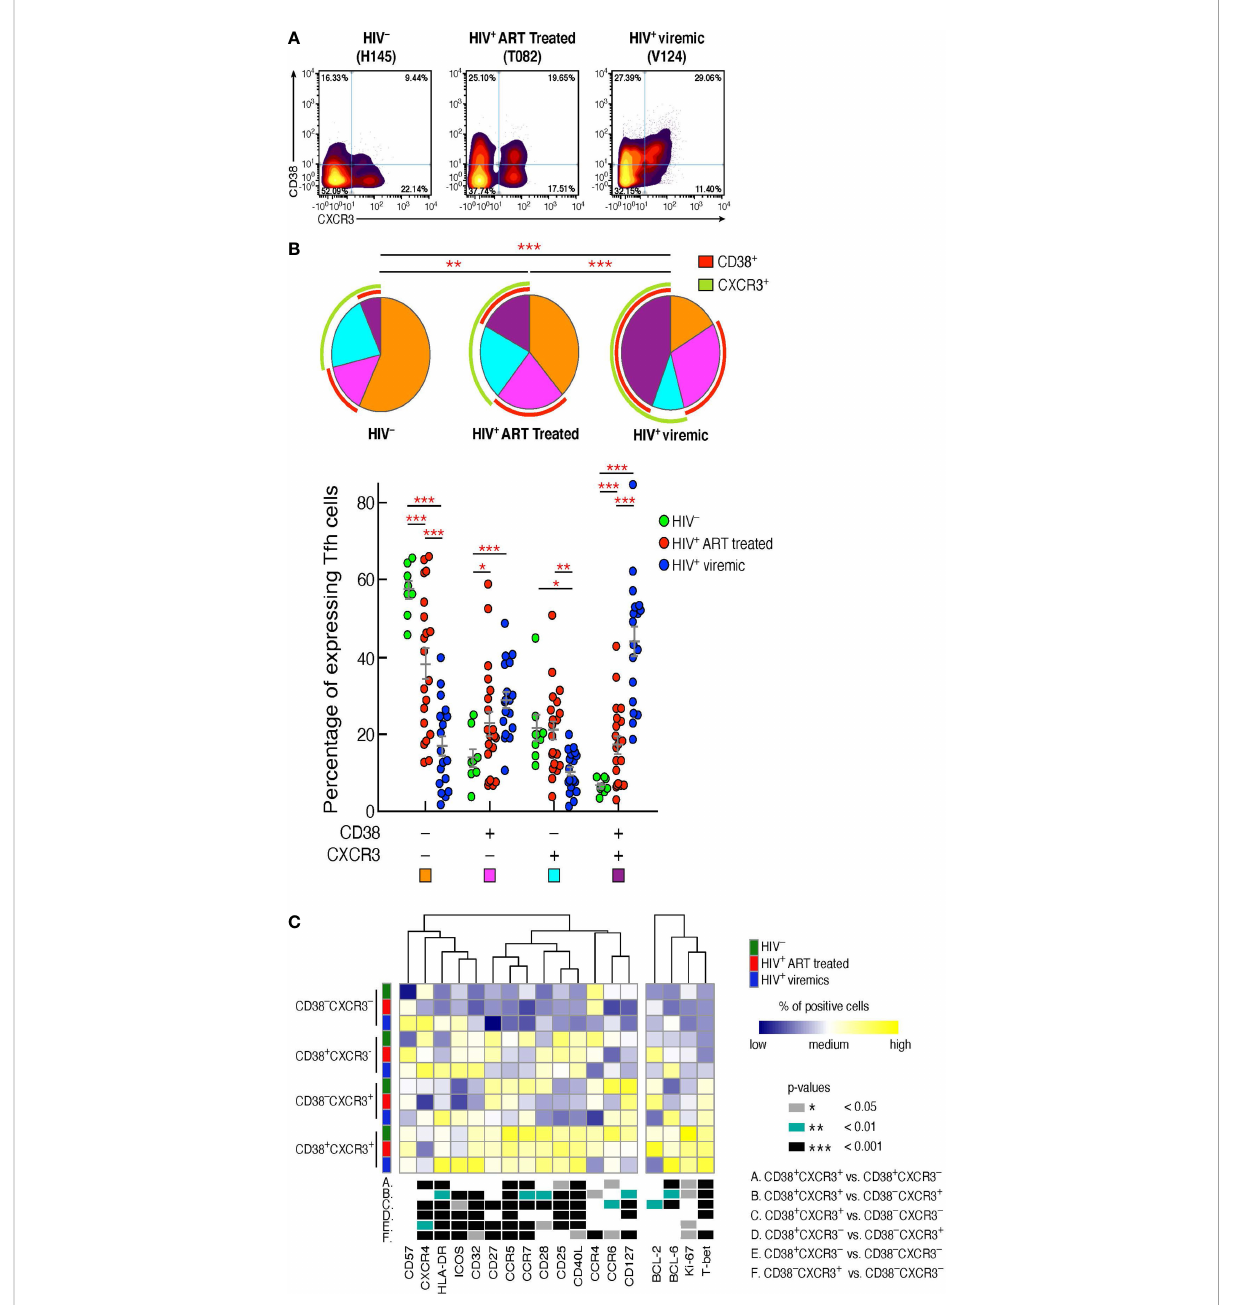
FIGURE 2 CD38 + CXCR3 + Tfh cells are increased in HIV-infected viremic individuals and represent a distinct Tfh population. Mass cytometry staining was performed on LN mononuclear cells isolated from 8 HIV uninfected, 20 HIV infected HIV-infected ART treated individuals and 18 untreated HIV-infected viremic subjects. Cells were stained with antibodies against PD-1, CXCR5, CD38, CXCR3. (A) Representative pro fi le by mass cytometry of Tfh cells gated on the basis of CD38 and CXCR3 from one representative HIV uninfected, one HIV-infected ART treated individuals and one viremic individual. (B) All the possible combinations of CD38 and CXCR3 expression are shown on the x axis, whereas the frequencies of the Tfh-cell populations are shown on the y axis. Pie charts represent all the possible combinations of the two markers. Arcs show the total proportion of the expression of the speci fi ed marker. Statistical analyses of the global CD38 and CXCR3 expression (pie charts) were performed by partial permutation tests using the SPICE software. (C) Heat map of scaled mean marker expression (percentage of positive cells) in Tfh cells de fi ned on the basis of CD38 and CXCR3 expression of 8 HIV uninfected, 12 HIV-infected ART treated individuals and 9 viremic individuals. The bottom panel shows signi fi cant differences between subsets of cells for all possible comparisons. Differences between subsets were calculated on all cohort samples using linear mixed-effect models. In (C) P values were obtained by linear regressions and corrected using FDR method with a cutoff of 0.05. Stars indicate statistical signi fi cance * P < 0.05, ** P < 0.01, *** P <